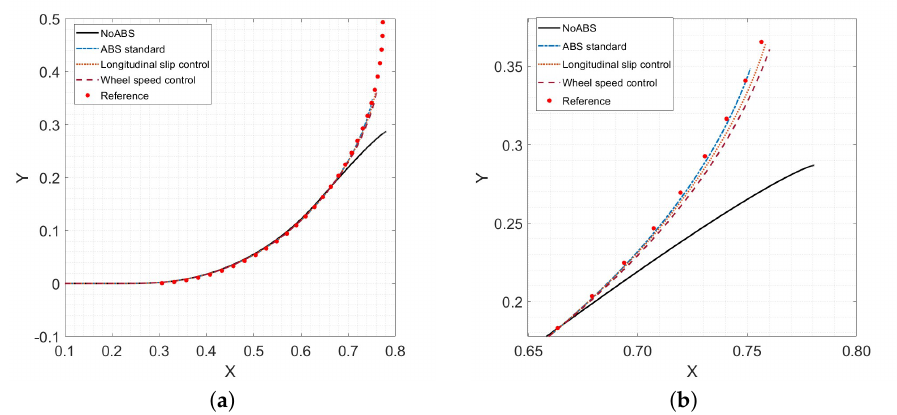
Figure 12. Vehicle Trajectory ( a ) and zoom of the trajectory ( b ) in combined braking from 80 to 0 km/h at lateral acceleration of 0.9 g with and without ABS ; X and Y stand for longitudinal and lateral vehicle